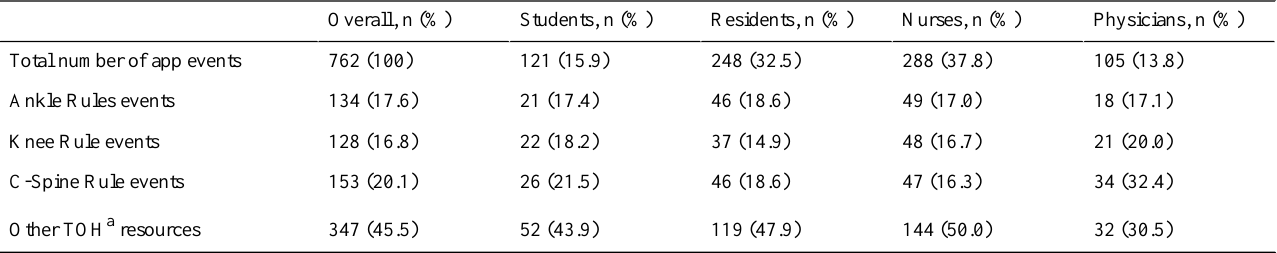
Table 2. In-app activity of study participants overall and by clinician